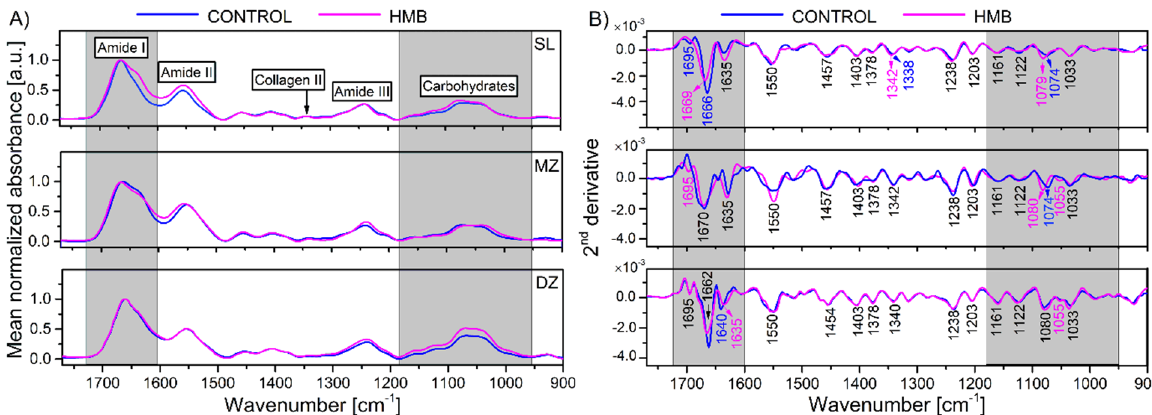
Figure 1. ( A ) Mean ( n = 75 spectra) FTIR spectra of the cartilage matrix from control (blue line) and HMB-treated pigs (magenta line) in three regions after background correction and normalization based on the amide I band intensity, and ( B ) mean second-derivative spectra from the same samples calculated using the Savitzky-Golay algorithm with nine smoothing points. The second-derivative band assignments were given in Table 1. The band positions in black indicate the same values for all samples. HMB—supplemented group, SZ—superficial zone, MZ—middle zone, DZ—deep zone.